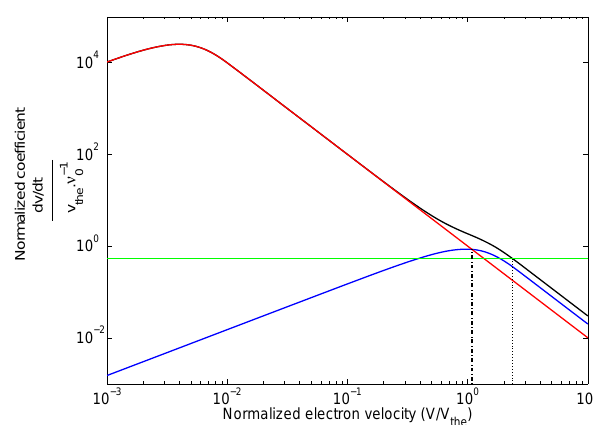
Fig. 1. The coefficient of friction due to e/e and e/i collisions are shown in blue and red, respectively. The coefficients are plotted as a function of normalized electron velocity. The total coefficient of friction is shown in black. The dashed-dotted line shows where e/e and e/i coefficients of friction are equal. The dotted line depicts the limit where the electric force is equal to the frictional